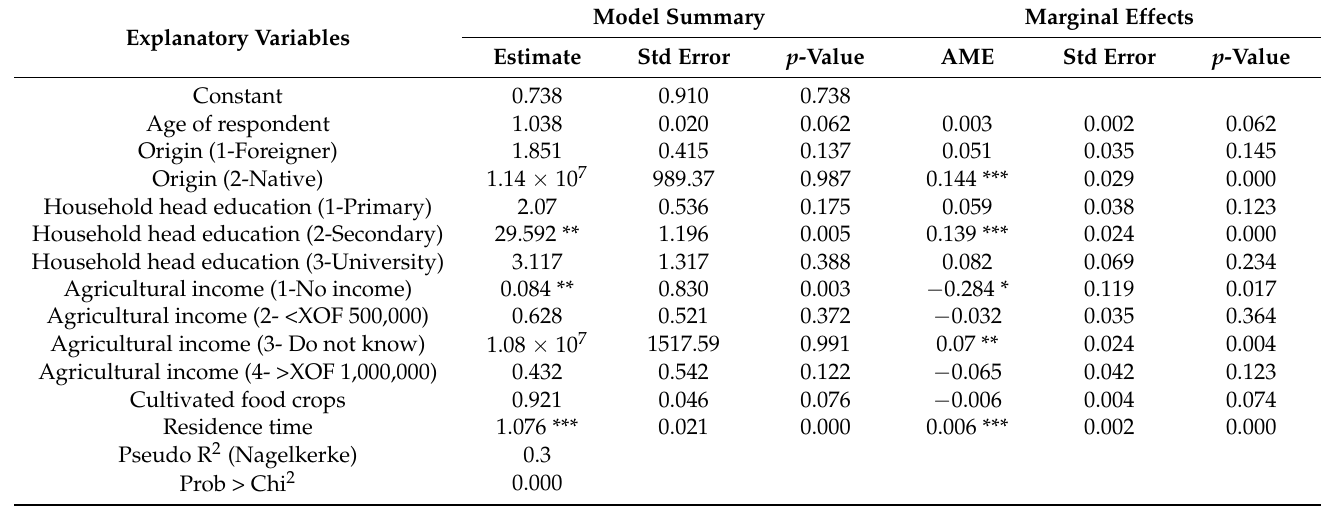
Table 6. Socioeconomic determinants affecting respondents on perceived